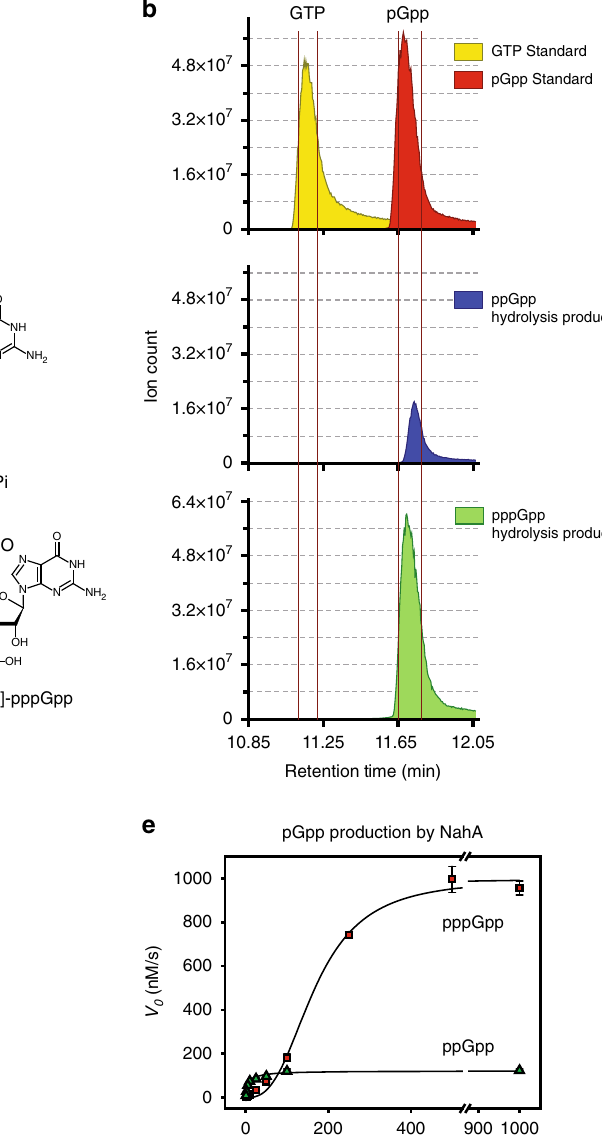
represent the best fi t of the data from three independent experiments. Error bars represent standard error of the mean.